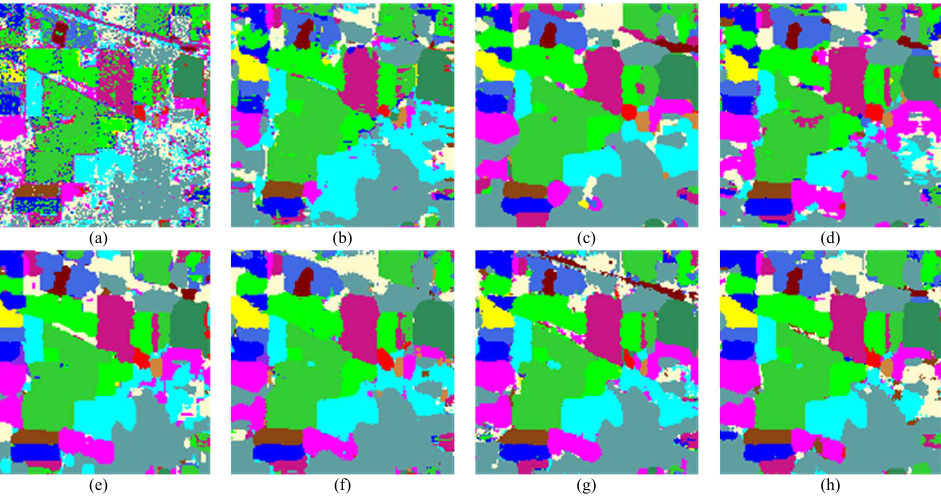
Figure 7. Classification maps of the IN data set obtained by: ( a ) SVM, ( b ) RNN, ( c ) SSRN, ( d ) DFFN, ( e ) RSSAN, ( f ) CBW, ( g ) SSAN, ( h )